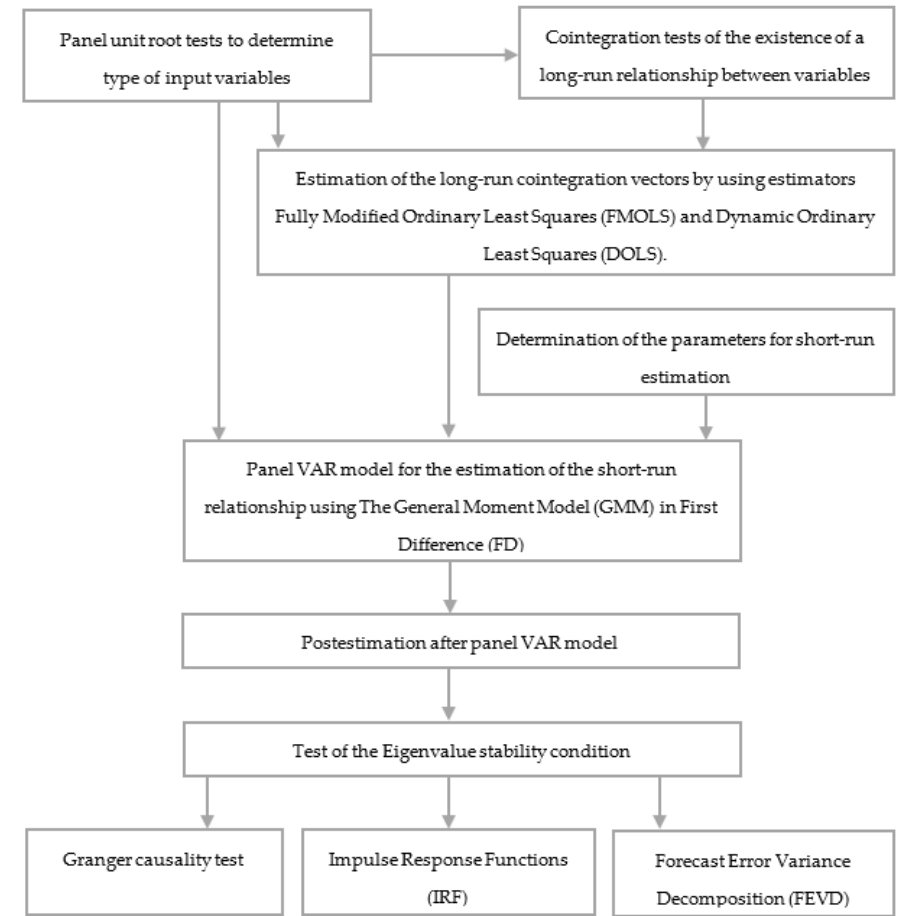
Figure 1. Methodology flowchart.